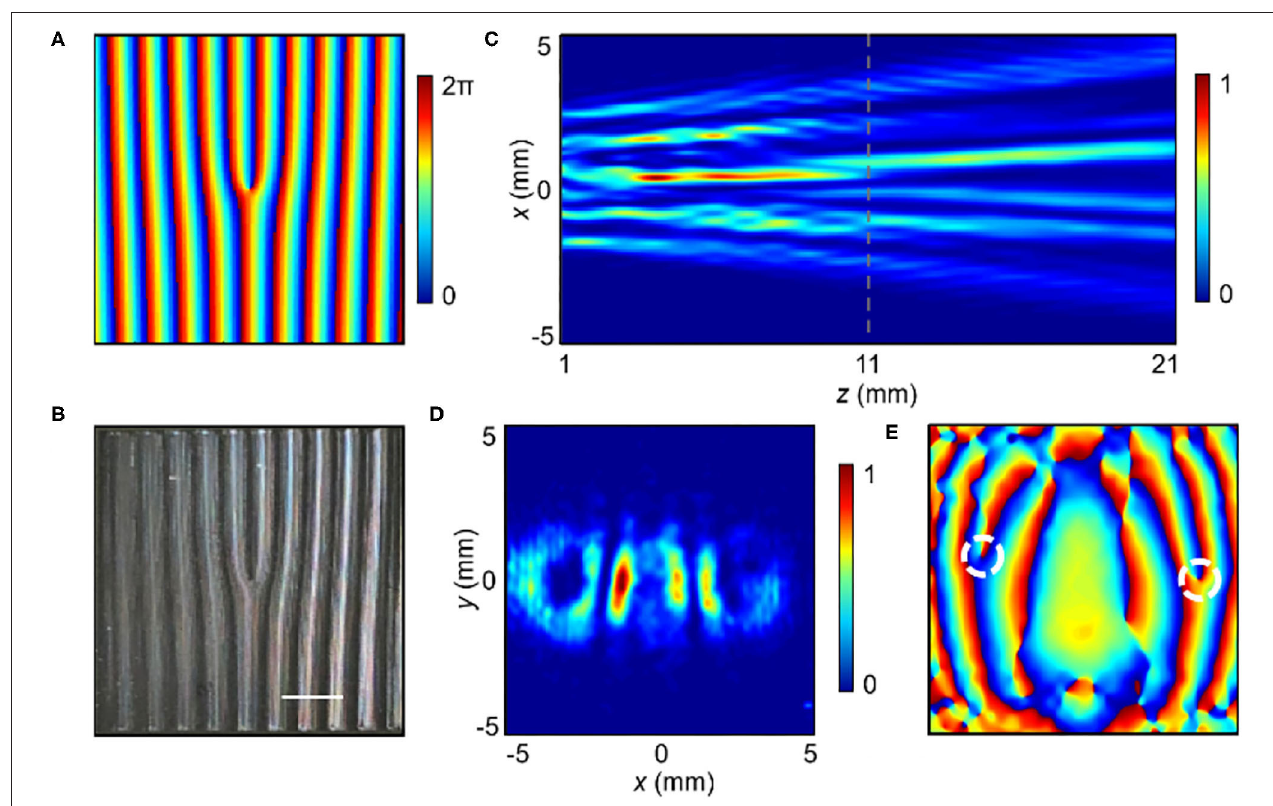
FIGURE 3 | Polarization fork grating. (A) Phase profile and (B) photograph of a polarization fork grating. The scale bar indicates 2mm. Measured intensity distributions in the (C) xz -plane and (D) xy -plane at z = 11mm. (E) Measured phase distribution at z = 11mm.